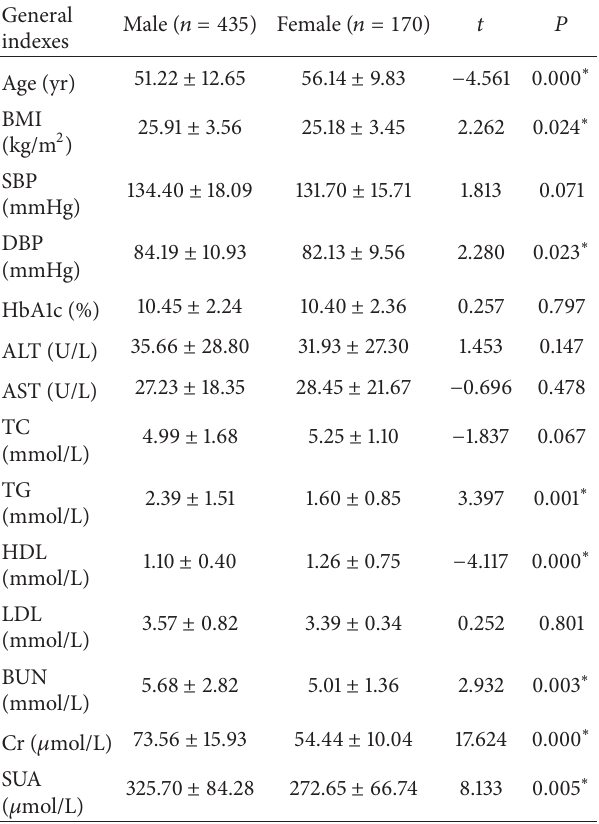
Table1:Basic/clinicalcharacteristicsofstudyparticipantsbygender and the difference between males and females ( 𝑥 ± 𝑠